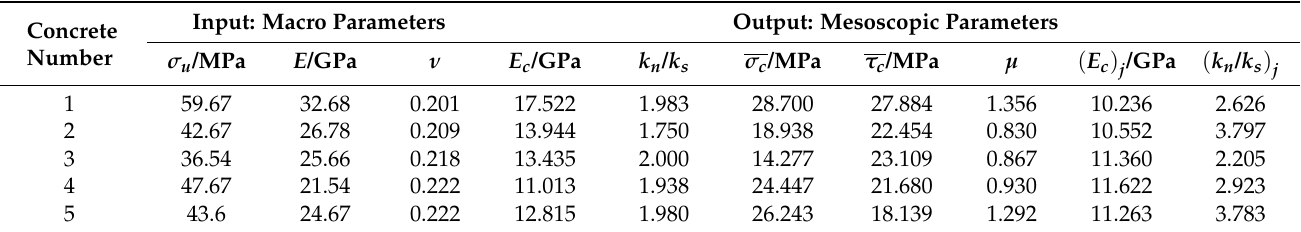
Table 14. Five groups of parameters and their optimal